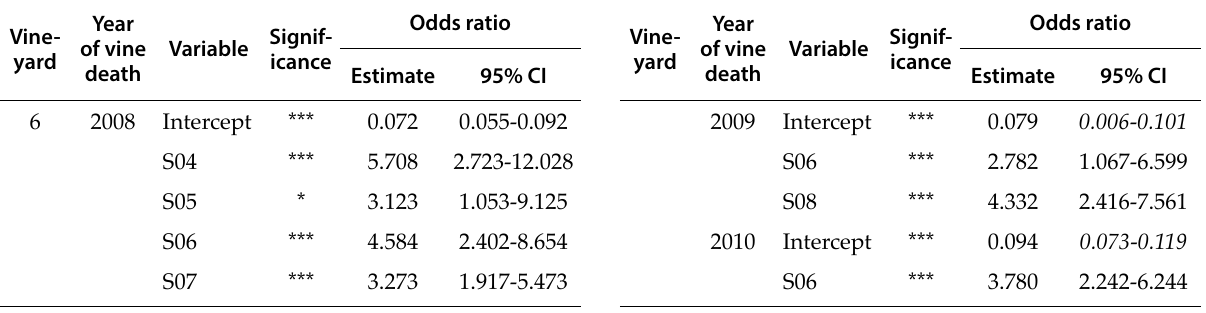
Table 2. Continues. Vine- yard